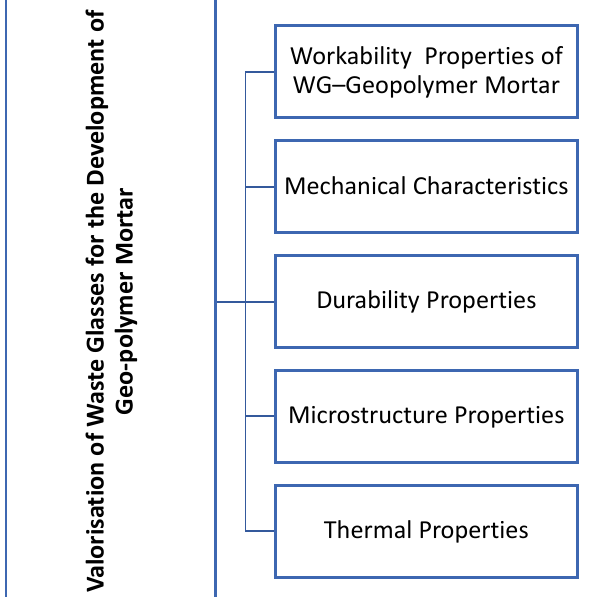
Figure 1. The structure of a manuscript.